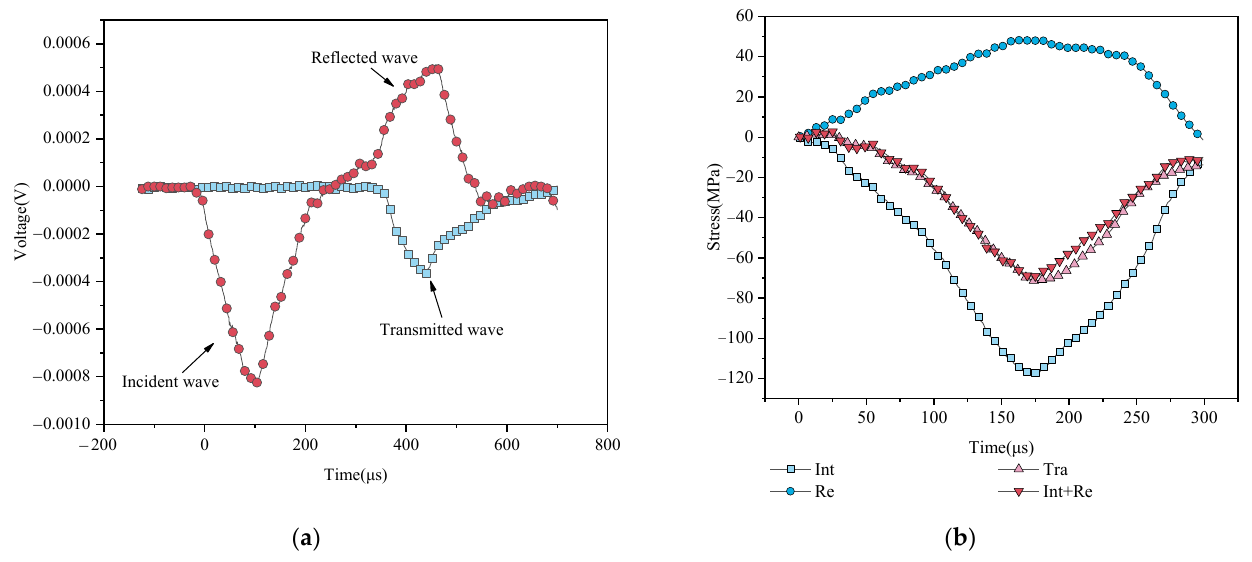
Figure 3. Trial experiment and dynamic stress equilibrium: ( a ) typical stress wave pattern of a tested rock specimen; ( b ) dynamic stress equilibrium.